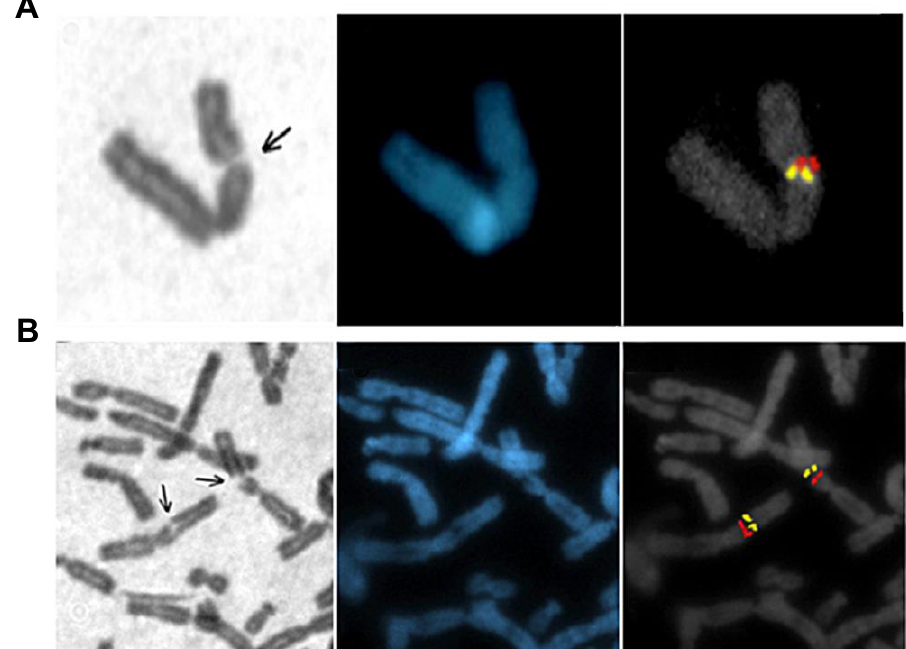
Figure 2. Genomic annotation of 1p31.1 and 3q13.3 fragile regions. ( A ) On the left, break on the short arm of chromosome 1 (1p31.1) was identified with Giemsa staining; in the middle, the same chromosome is visualized with 4′,6′-diamidino-2-phenylindole hydrochloride (DAPI). Distal and proximal probes flanking the common fragile sites (CFSs) are localized, in the same chromosome, through subsequent fluorescent in situ hybridization (FISH) staining (panel on the right). ( B ) On the left, identification of a fragile region on chromosome 3 (3q13.3) using Giemsa staining; in the middle, the same region is visualized with DAPI staining and by FISH of distal and proximal probes flanking the CFS (panel of the right). The arrows show the fragile site location.